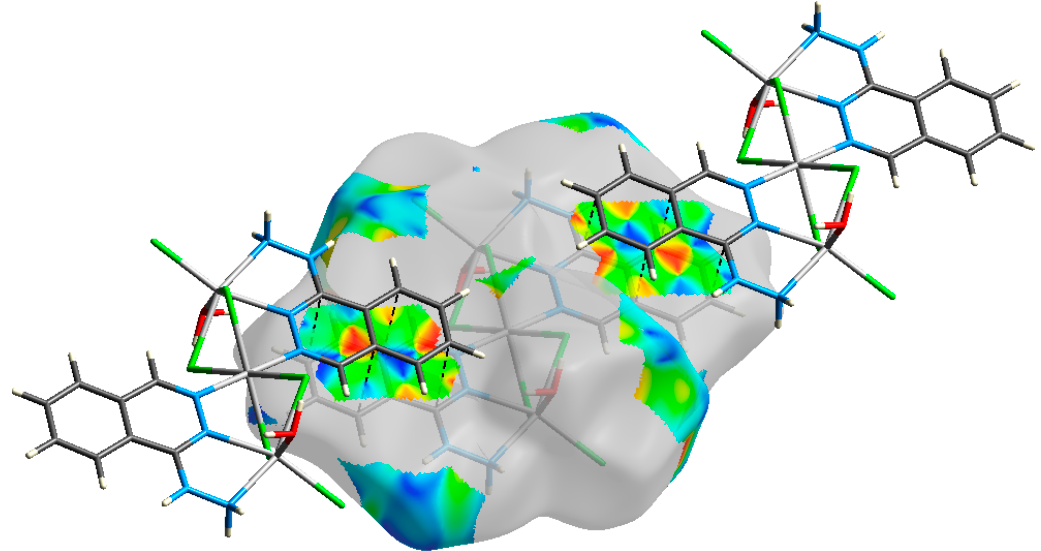
Figure 16. The red/blue triangles in the shape index revealed the weak π - π stacking interactions between the almost parallel phthalazine moieties in complex 3 .